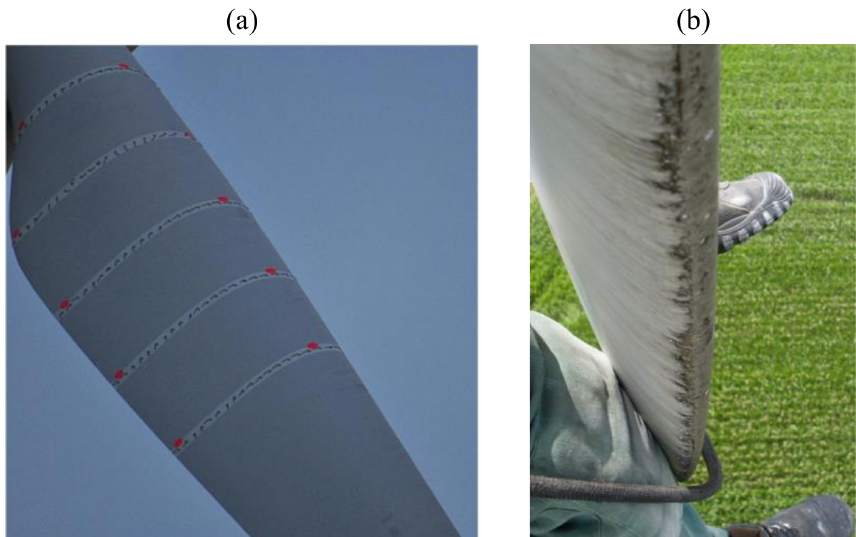
Figure 1. Rotor blades of utility-scale wind turbines. (a) Flow indicators to detect early separation in the inner blade region, reproduced from Pechlivanoglou et al. (2013). (b) Leading-edge erosion, with permission from Seilpartner Windkraft GmbH.